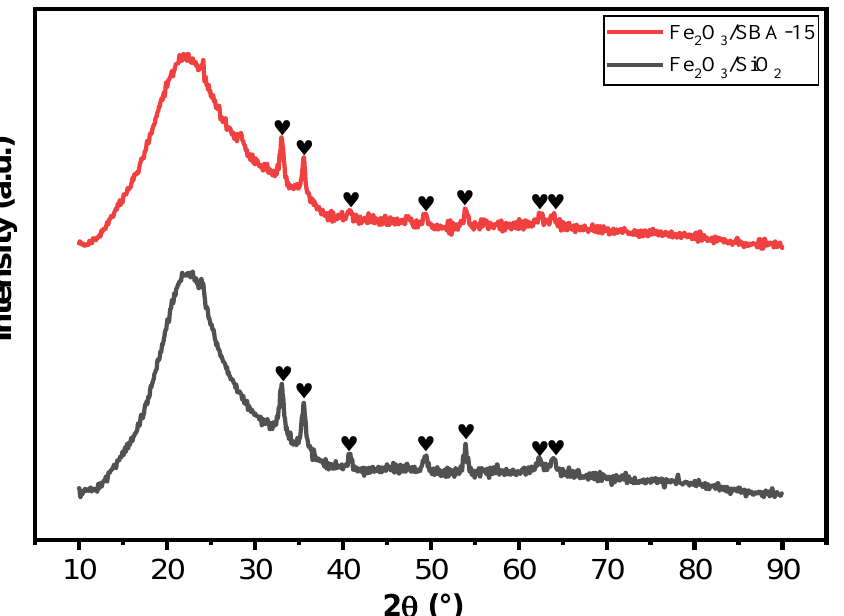
Figure 3. XRD patterns of Fe 2 O 3 /SBA-15 and Fe 2 O 3 /SiO 2 .